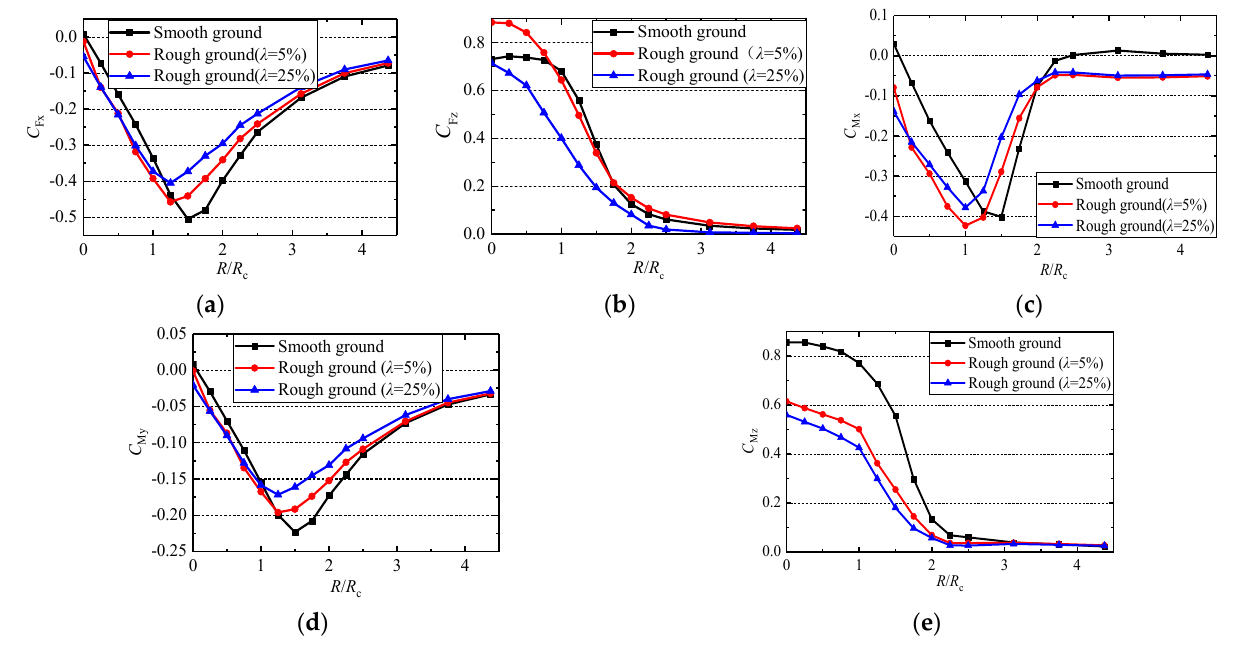
Figure 20. Variation of the wind force coefficients with R/Rc under different ground roughness levels ( S = 0.35). ( a ) C FX ; ( b ) C FZ ; ( c ) C MX ; ( d ) C MY ; ( e ) C MZ .